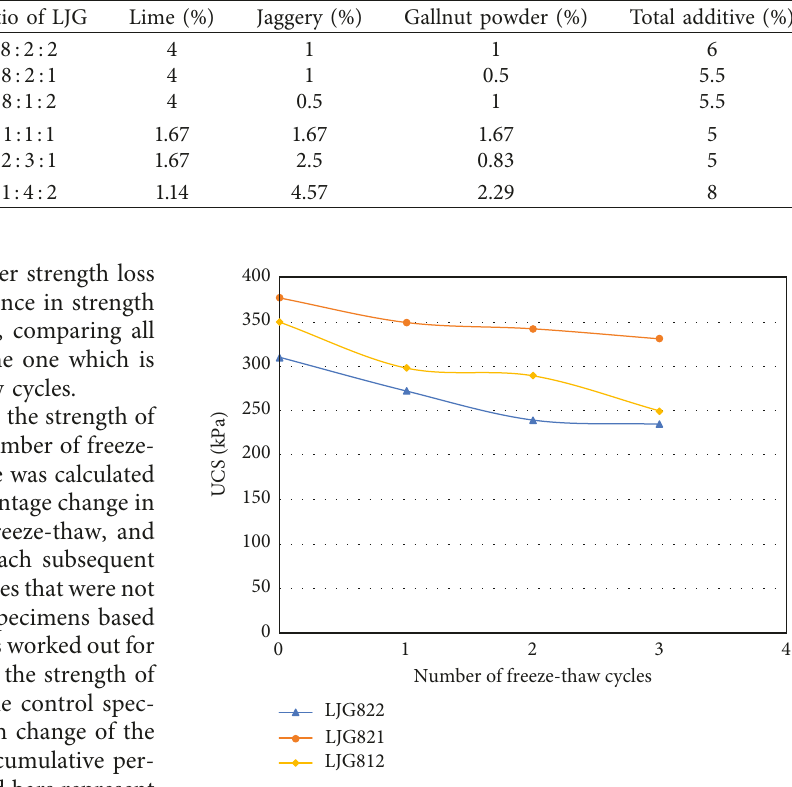
Figure 6: Effect of freeze-thaw cycles on UCS of stabilized soil.